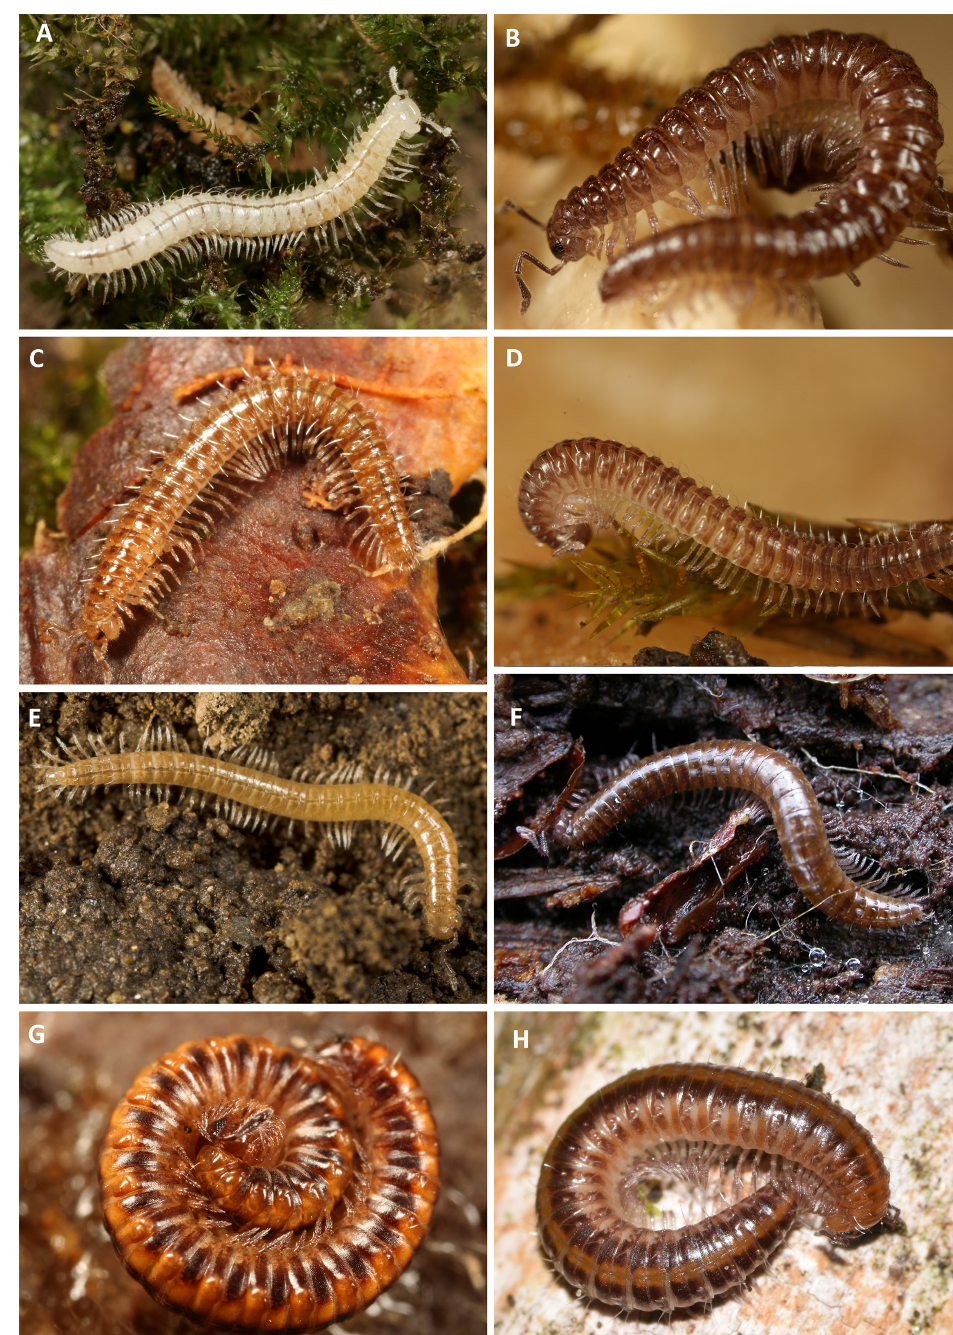
Fig. 3. A selection of European species of Chordeumatida C.L. Koch, 1847, various families. A . Psichrosoma cf. breuli (Mauriès, 1970) (Vandeleumatidae Mauriès, 1970). B . Turdulisoma cf. helenreadae Mauriès, 2015 (Haplobainosomatidae Verhoeff, 1909). C . Hylebainosoma nontronense Mauriès & Kime, 1999 (Haaseidae Attems, 1899). D . Anamastigona pulchella (Silvestri, 1894) (Anthroleucosomatidae Verhoeff, 1899). E . Melogona gallica (Latzel, 1884) (Chordeumatidae C.L. Koch, 1847). F . Chordeuma proximum Ribaut, 1913 (Chordeumatidae). G . Ceratosphys amoena Ribaut, 1920 (Opisthocheiridae Ribaut, 1913). H . Mastigona mutabilis (Latzel, 1884) (Mastigophorophyllidae Verhoeff, 1899). Photo credits: Paul Richards, www.flickr.com/invertimages (A–E, G), Trevor and Dilys Pendleton (F), Jörg